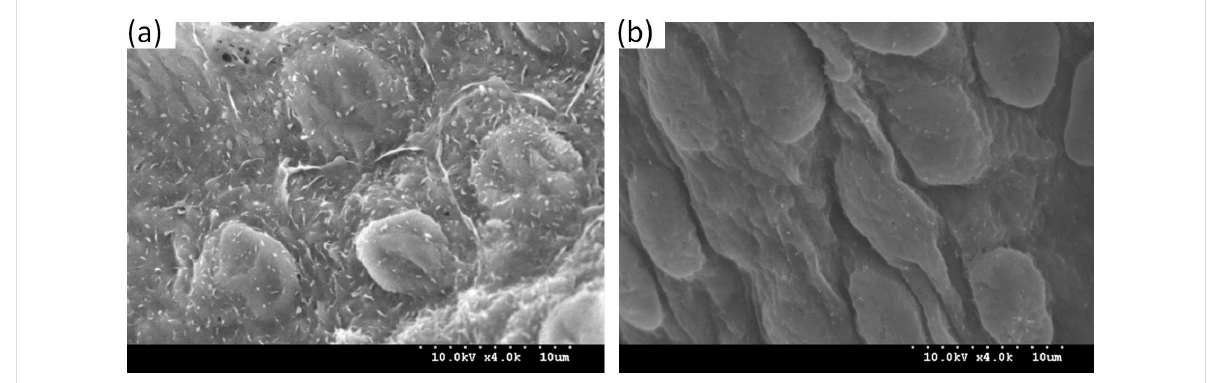
Figure 5: SEM images of the microstructure on the mitral valve leaflets surface: (a) non-heparinized; (b) heparinized.